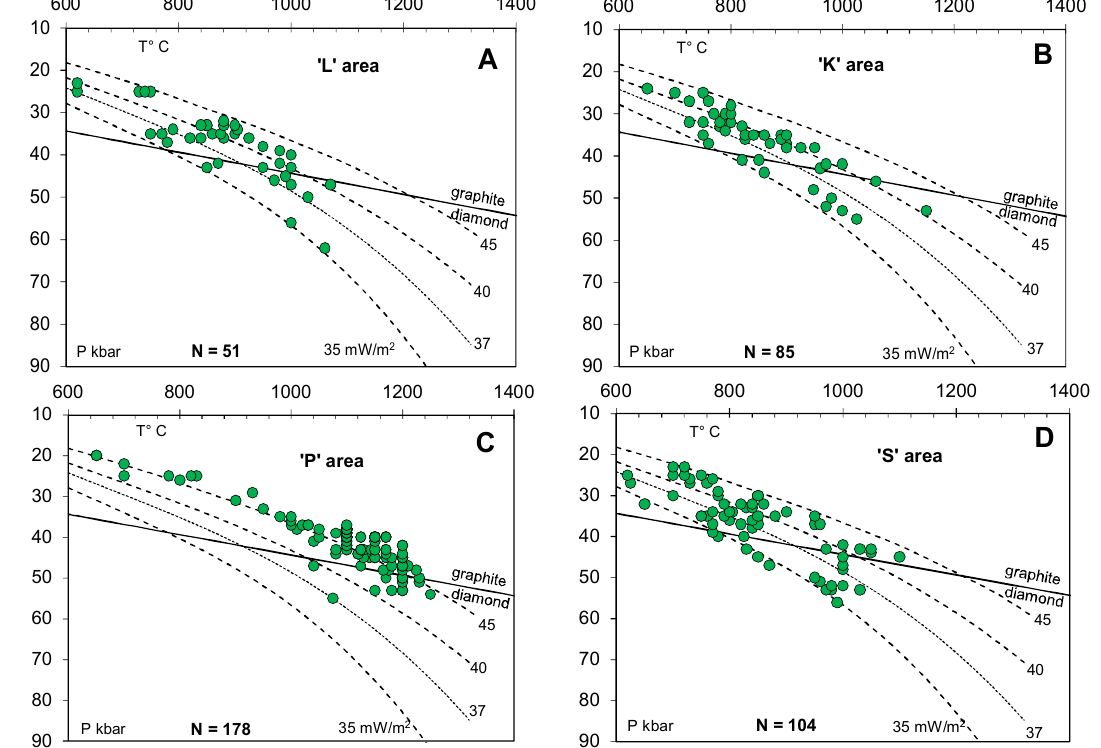
Figure 7. P-T data [45] for Cr-diopside. N, total grains analyzed. Reference geotherms [46]. ( A ) ‘L’ area; ( B ) ‘K’ area; ( C ) ‘P’ area; ( D ) ‘S’ area.